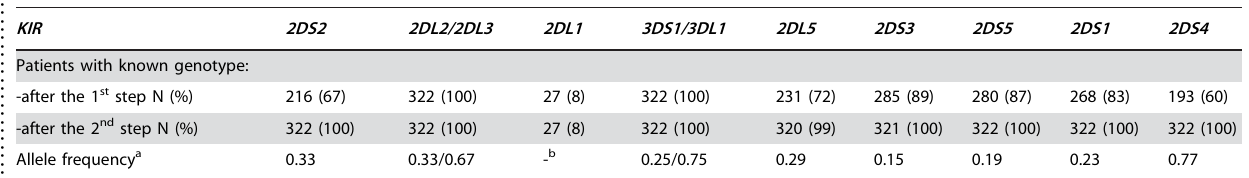
Table 1. Summary of the genotypic reconstruction results for the nine variable KIR genes in 322 subjects. The procedure